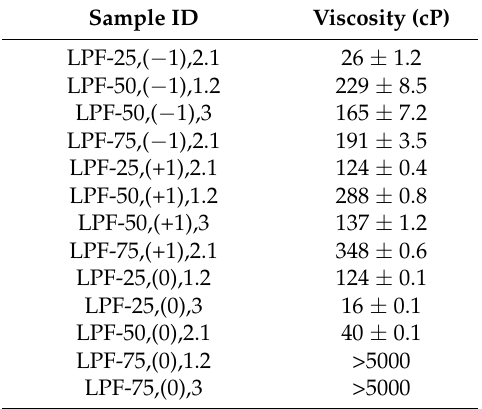
Table 3. Viscosity of all BPF resoles synthesized in this study.